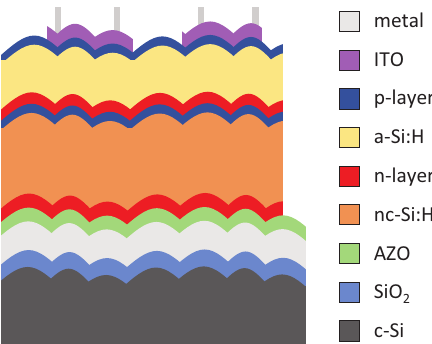
Fig. 3. Schematic structure of the solar cells. Note that Ag is used as a metal back contact, while Al is used for the metal